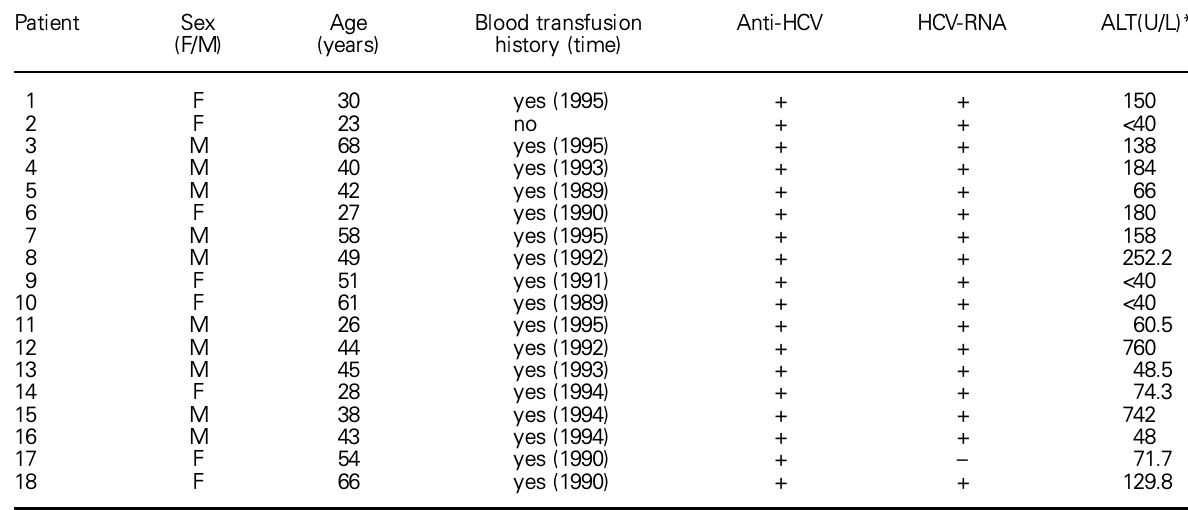
Table 1. Details of individuals with chronic HCV infection Patient Sex (F/M)